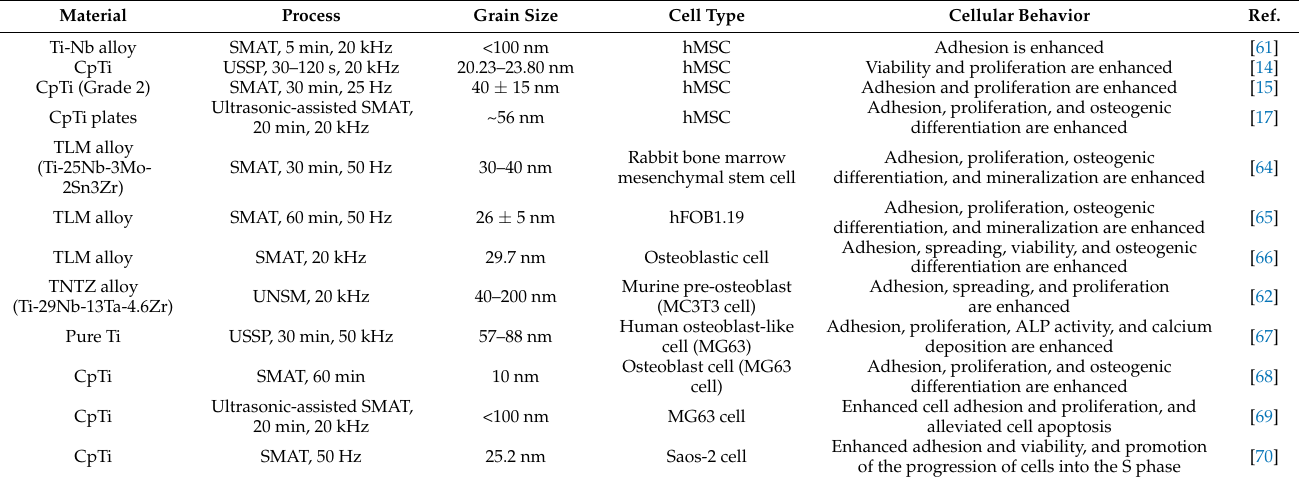
Table 1. Cell response to titanium and its alloys after surface grain refinement.